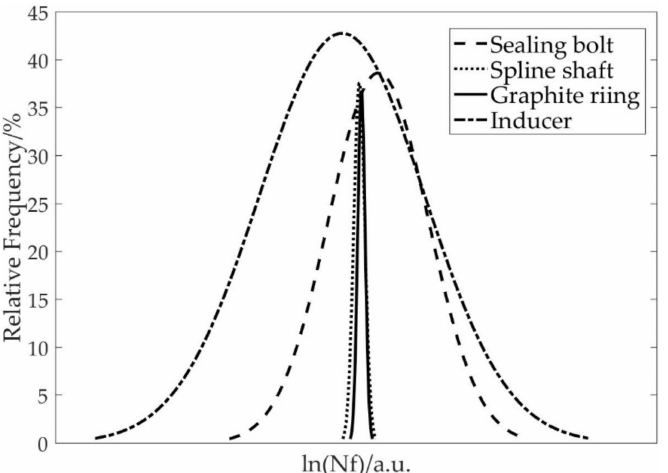
Figure 12. The logarithmic life fitting curve of key